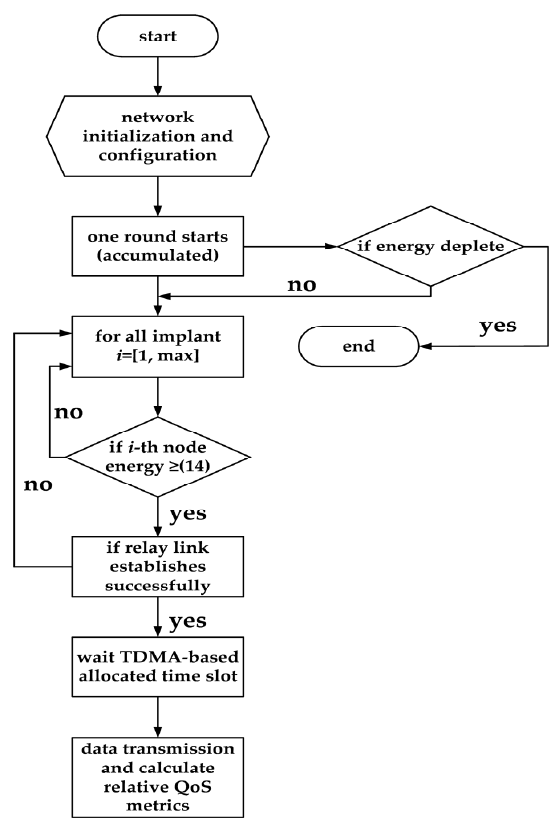
Figure 11. The information flow for the proposed protocol.